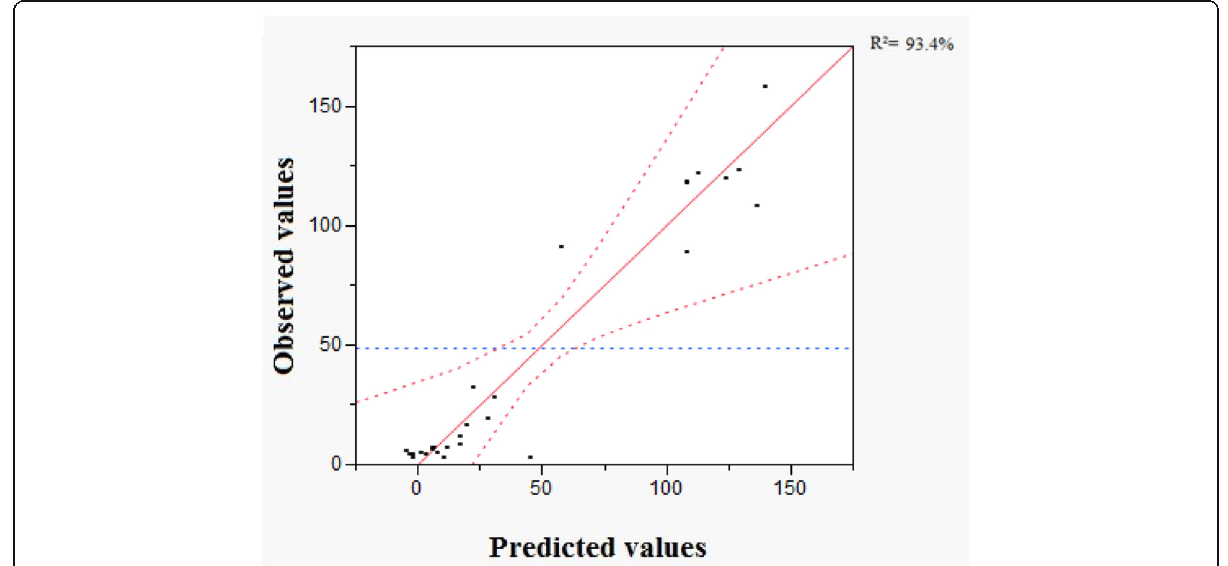
Fig. 3 Curve of observed values in term of predicted